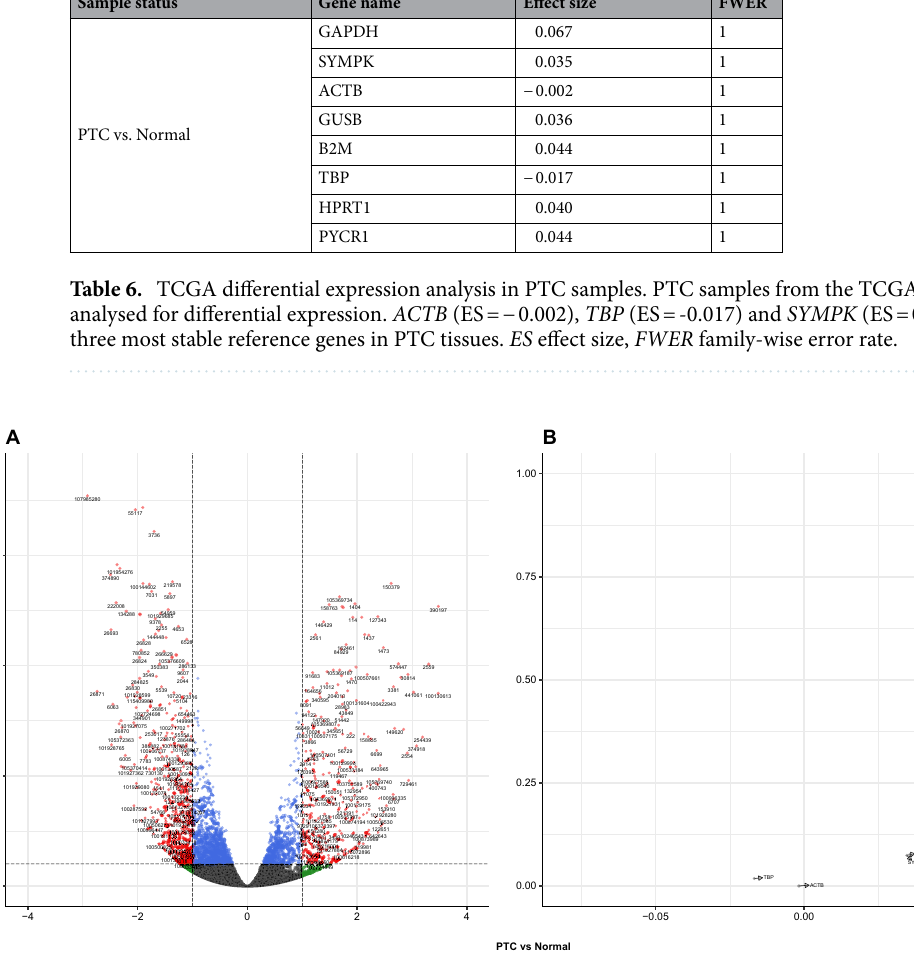
Figure 7. TCGA volcano plots of differentially expressed genes and selected reference genes in the PTC subtype. ( A ) all genes and ( B ) selected reference genes of PTC versus normal